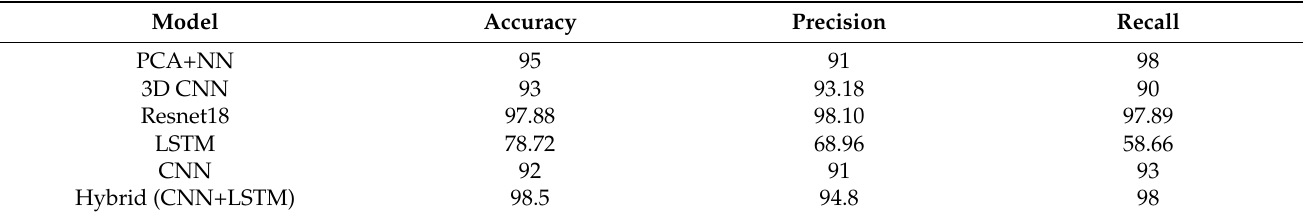
Table 2. Accuracy, precision,